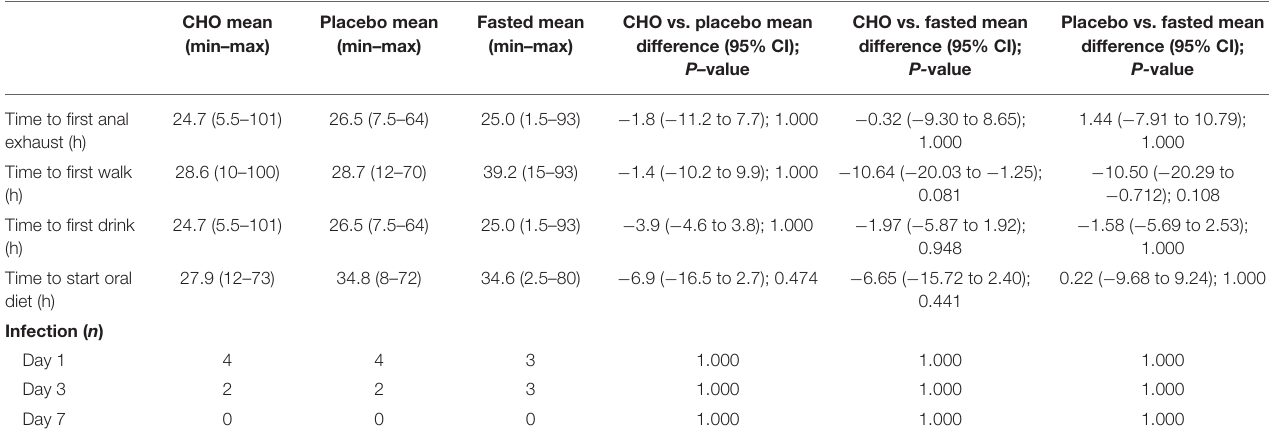
TABLE 4 | Comparison among the postoperative rehabilitation indices of the three